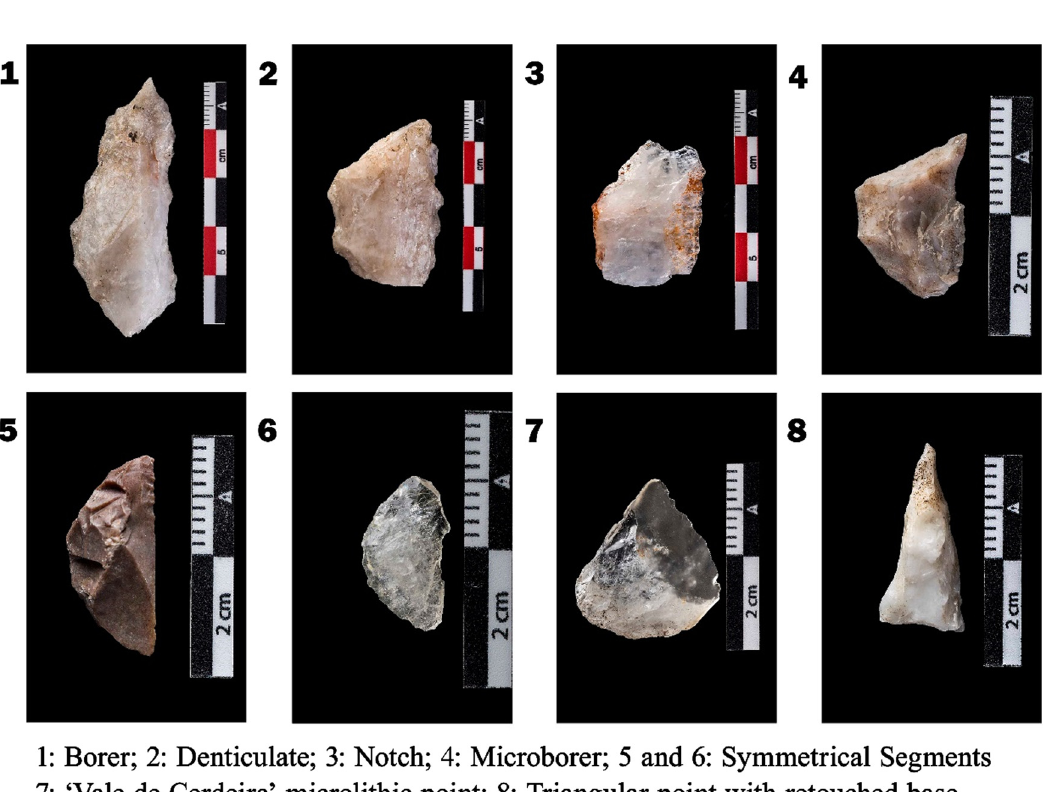
Figure 11: Tools from stratigraphic unit 2 ( Photographs by Adriano Borges )